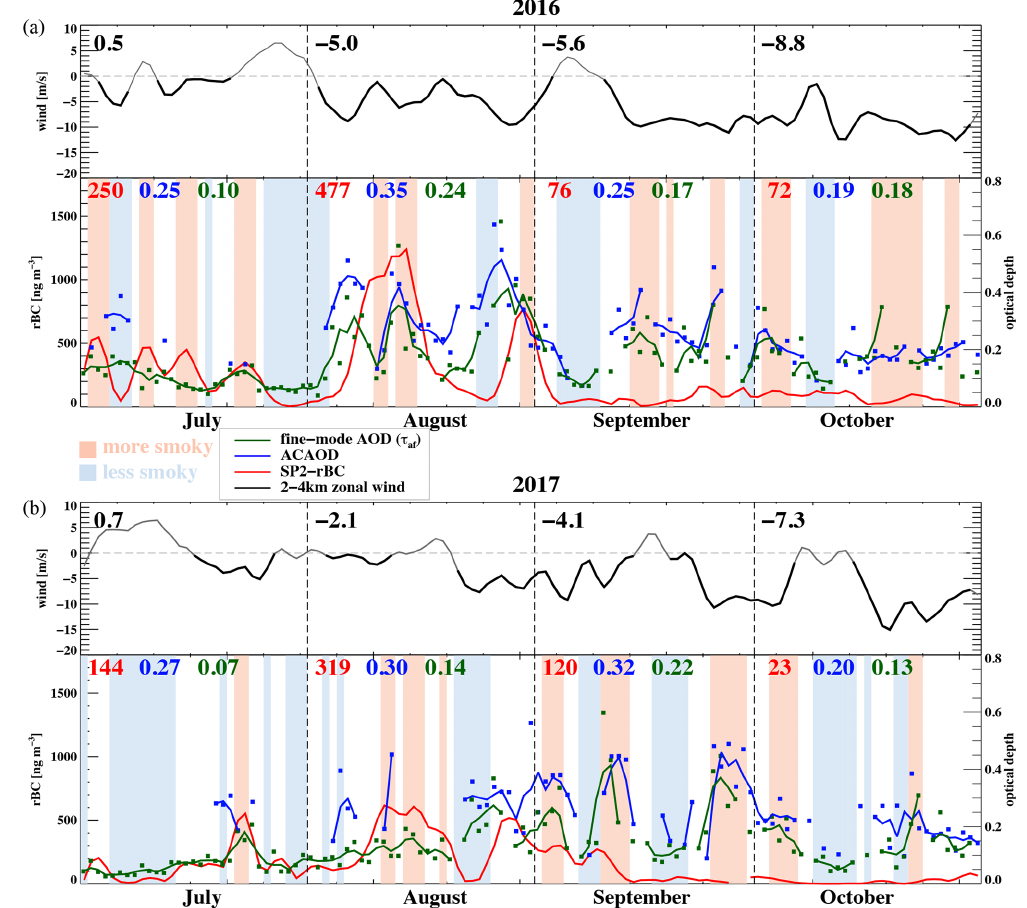
Figure 3. Time series of daily rBC mass concentrations (red), ACAOD (blue), τ af (dark green), and 2–4km mean zonal winds (gray or black) from July through October for (a) 2016 and (b) 2017. A 3d running mean is applied to all, easterlies lasting at least 5d are highlighted with a thicker black line, and monthly mean values are indicated. More (less) smoky composites are indicated by light red (light blue) shading.